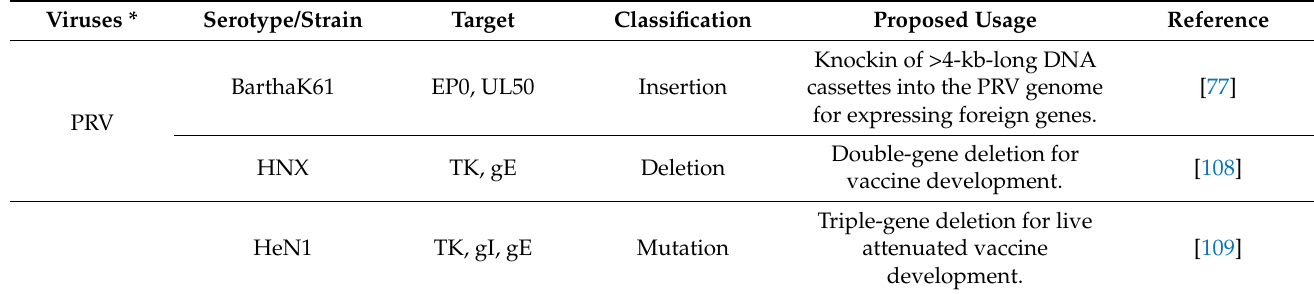
Table 1. Virus species reconstituted for animal vaccine development by the CRISPR/Cas9-based gene editing techniques. Viruses *